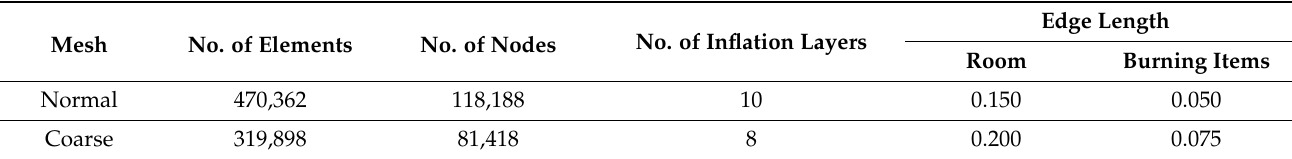
Table 3. Parameters of the applied meshes.